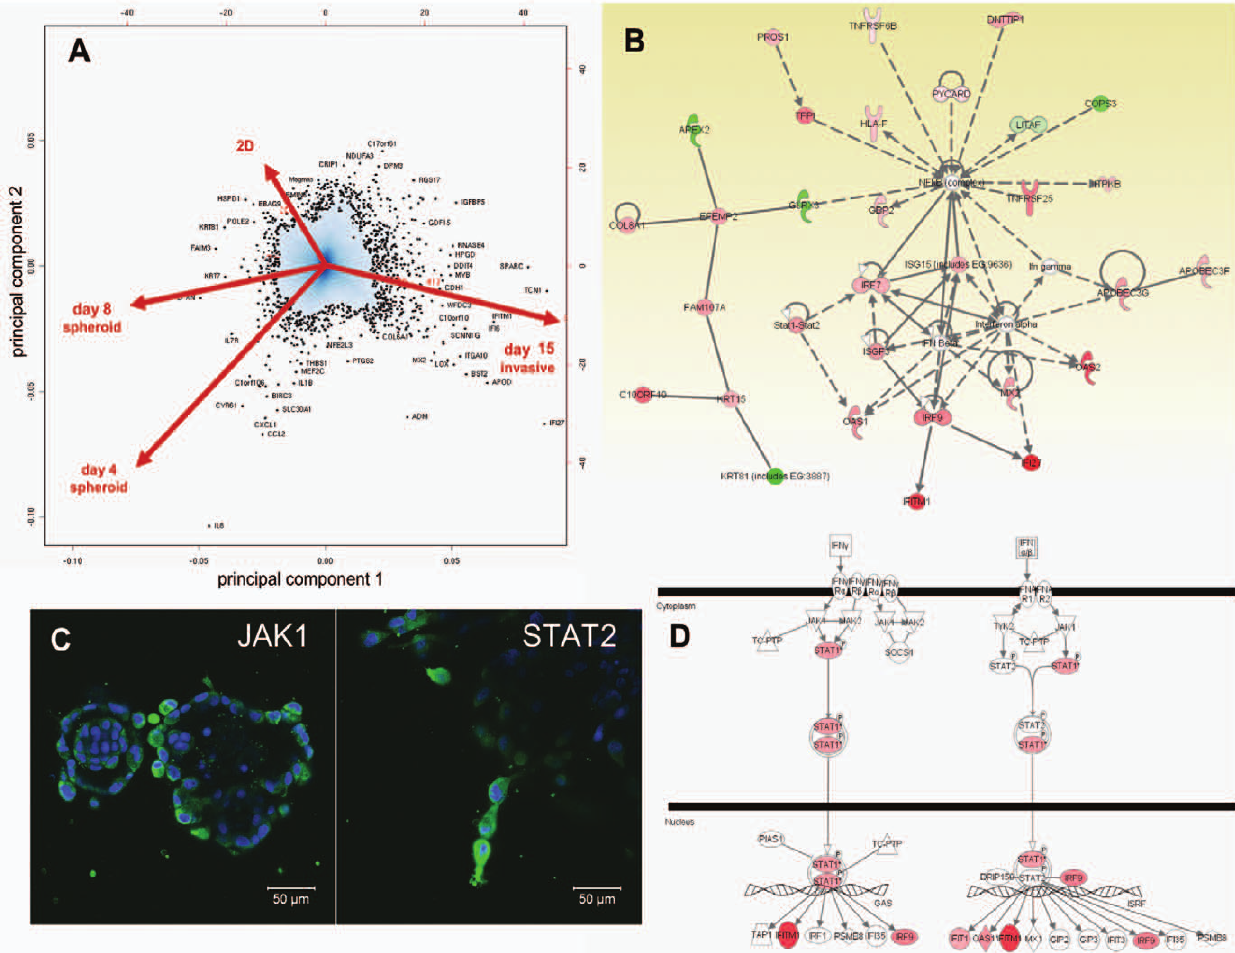
Figure 7. Functional analysis of dynamic gene expression changes observed in PC-3 cells, which correlate with the morphologic transformation of round to stellate spheroids. A) Principal component analysis PCA. Genes highlighted by arrows correlate best with PC-3 cells in monolayer (2D) culture, or round (day 4 + 8) and stellate phenotype (day 13 + 15) in 3D. B) IPA gene network analysis illustrating cross-talk between STAT1/STAT2, interferon a / b , and NF k B signaling in invasive cells (colors indicate factors of altered expression; red = induced, green = repressed). C) Immune staining of JAK1 and STAT2 protein expression in stellate PC- 3 spheroids. STAT2 signal is highest in invasive structures, JAK1 in peripheral cells. D) IPA: Schematic representation of Interferon c and a / b signal transduction pathways, colors corresponding to fold changes of gene expression.